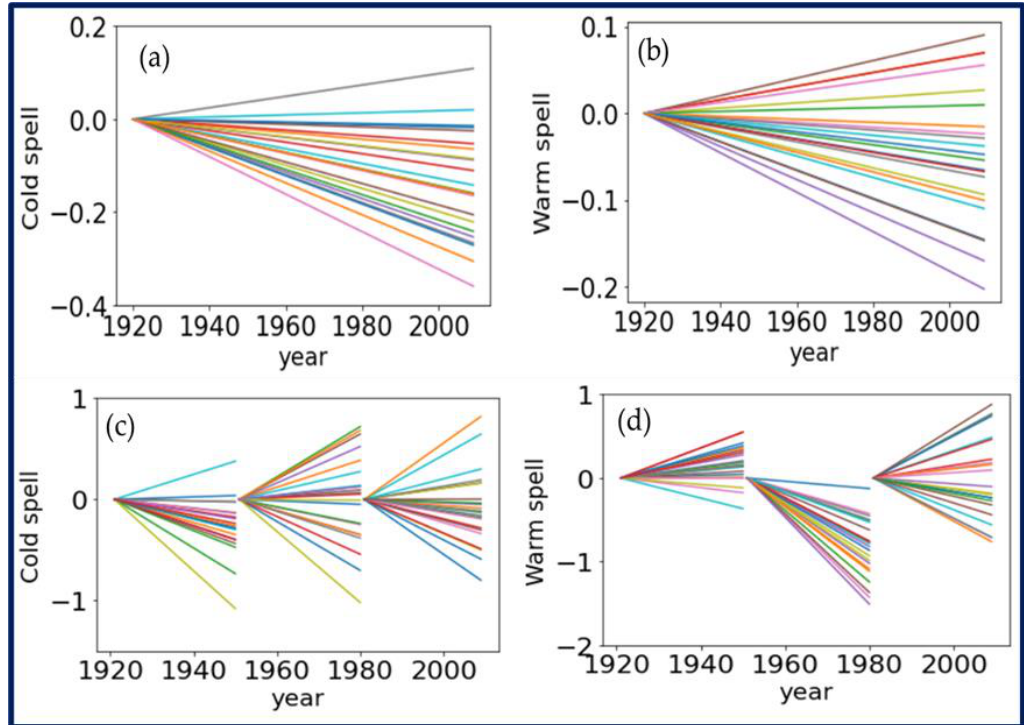
Figure 12. Kansas station trends in the annual cold spell days between 1980 – 2009 ( a ) and annual warm spell days ( b ). The data in ( c , d ) is the same as that in ( a , b ), respectively except that it is for the three periods, 1921 – 1950, 1951 – 1980, and 1981 – 2009.